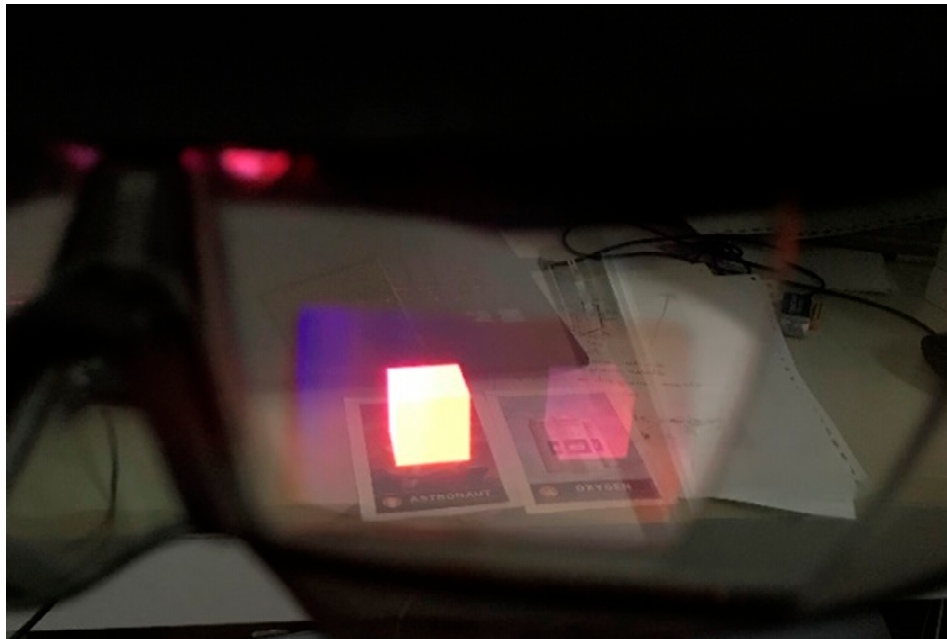
Figure 8. Solid red cube on the left and solid black cube (which is transparent but visible thanks to refraction) on the right in the Microsoft HoloLens display. Experiment carried out at University of Bologna by the authors.